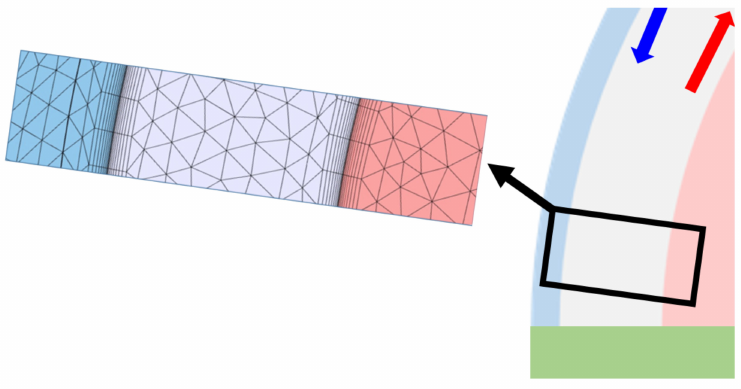
Figure 2. The adopted mesh.